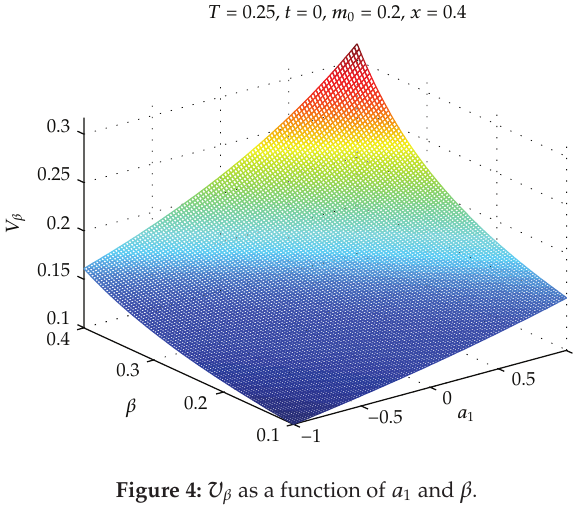
Figure 4: V β as a function of a 1 and β .